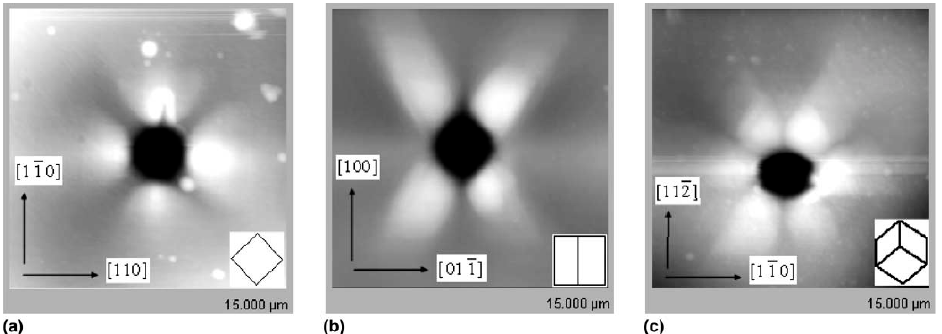
Figure 11. Experimentally observed contour plots of the pile-up patterns on ( a ) (001), ( b ) (011) and ( c ) (111) oriented copper single crystal surfaces after indentation with a conical indenter [40]. Reproduced with permission from Y. Wang et al., Acta Materialia; published by Elsevier, 2004.